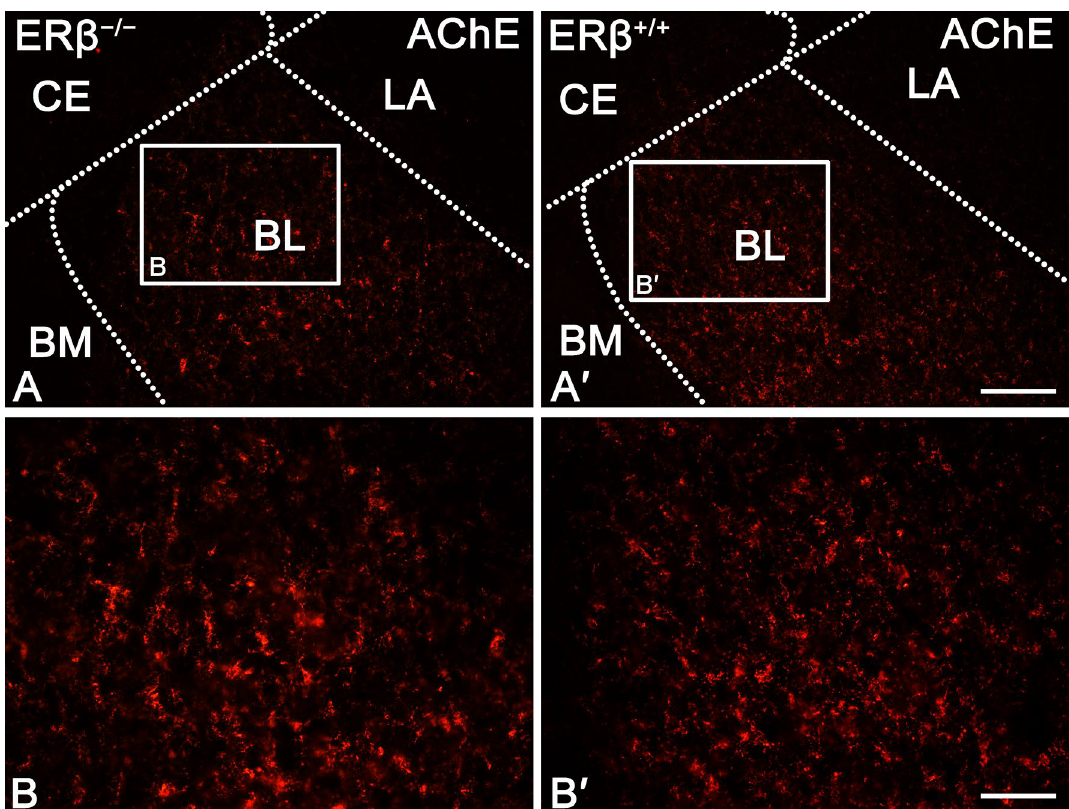
Figure 6. Representative colour photomicrographs illustrating the staining pattern of acetylcholinesterase (AChE) in the amygdala of ERβ knock-out (ERβ −/− ) and wild-type (ERβ +/+ ) mice, n = 6 per group. ( A , B ) ERβ −/− mice. ( A ′ , B ′ ) ERβ +/+ mice. Note similar density and signal intensity of AChE in ERβ −/− ( A , B ) and ERβ +/+ mice ( A ′ , B ′ ). LA—lateral nucleus, BL—basolateral nucleus, BM—basomedial nucleus and CE—central nucleus. The scale bar applies to all microphotographs, and it corresponds to the length of 100 µm in ( A , A ′ ), and 50 µm in ( B , B ′